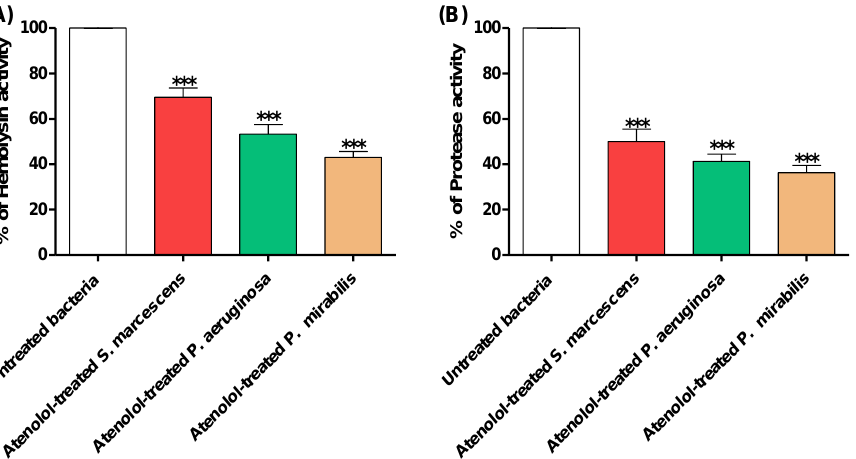
Figure 11. Atenolol decreased the production of ( A ) Hemolysins, and ( B ) Protease production in S. marcescens , P. aeruginosa , and P. mirabilis . Atenolol at sub-MIC significantly reduced the production of hemolysins and protease (***: p ≤ 0.001). The data are presented as percentage change from untreated controls.